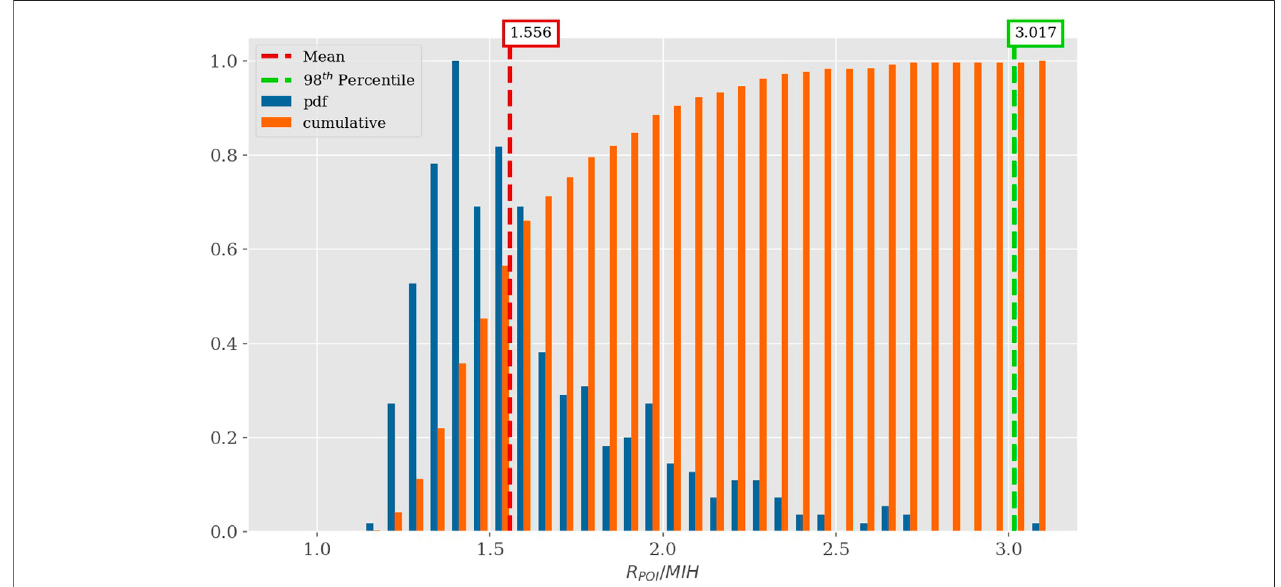
FIGURE 3 | Empirical probability density function (EPDF, blue bars) and empirical cumulative density function (ECDF, orange bars) of the ratio between the maximum Run-up ( R d ) and the mean of the maximum inundation height ( MIH ) at each POI.